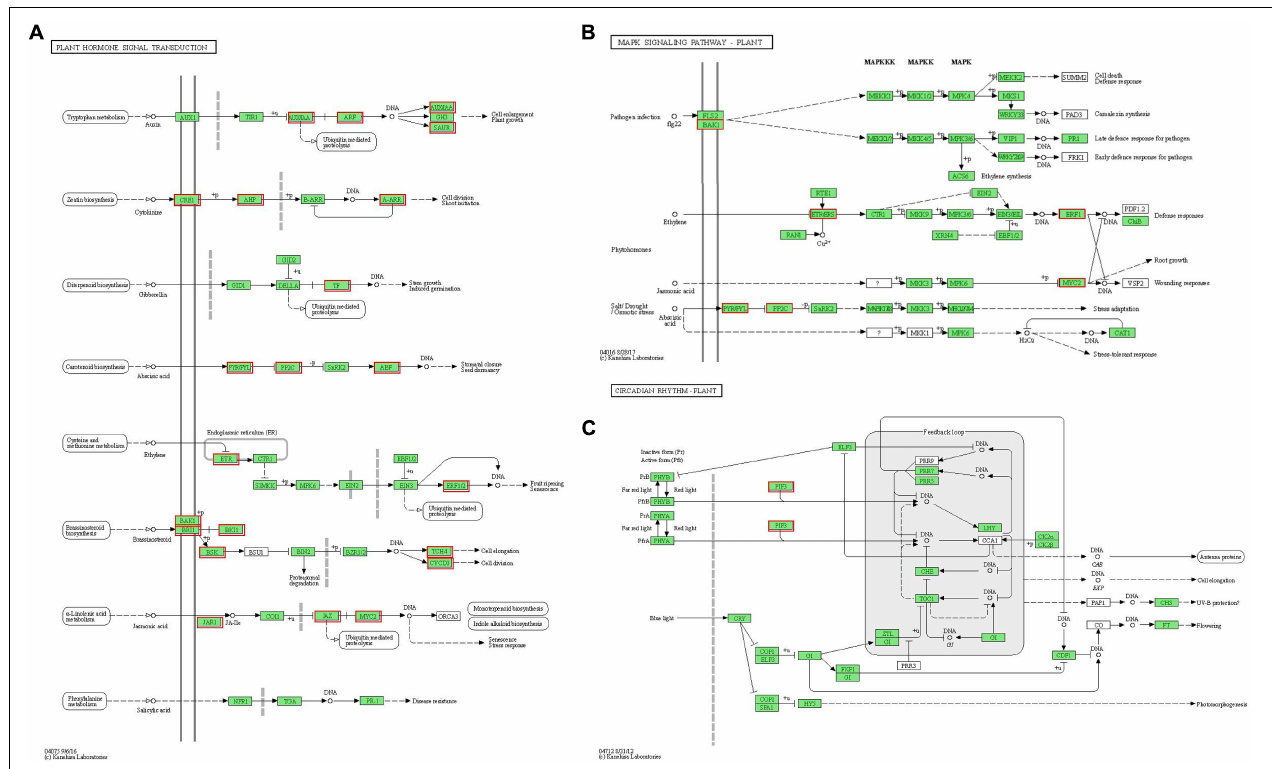
FIGURE 8 | Differentially expressed genes involved in plant hormone signal transduction pathway. (A) The DEGs involved in the “Plant hormone signal transduction” pathway. (B) The DEGs involved in the “MAPK signaling pathway-plant” pathway. (C) The DEGs involved in the “Circadian rhythm-plant” pathway. The red boxes indicated the DEGs were involved in different hormone signal transduction